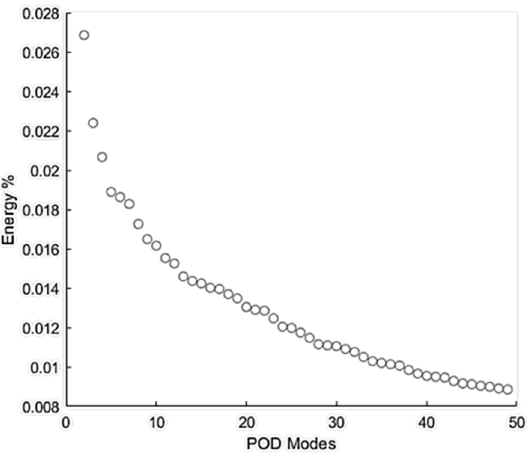
Figure 9. Energy % distribution of the first 50 proper orthogonal decomposition (POD) modes of